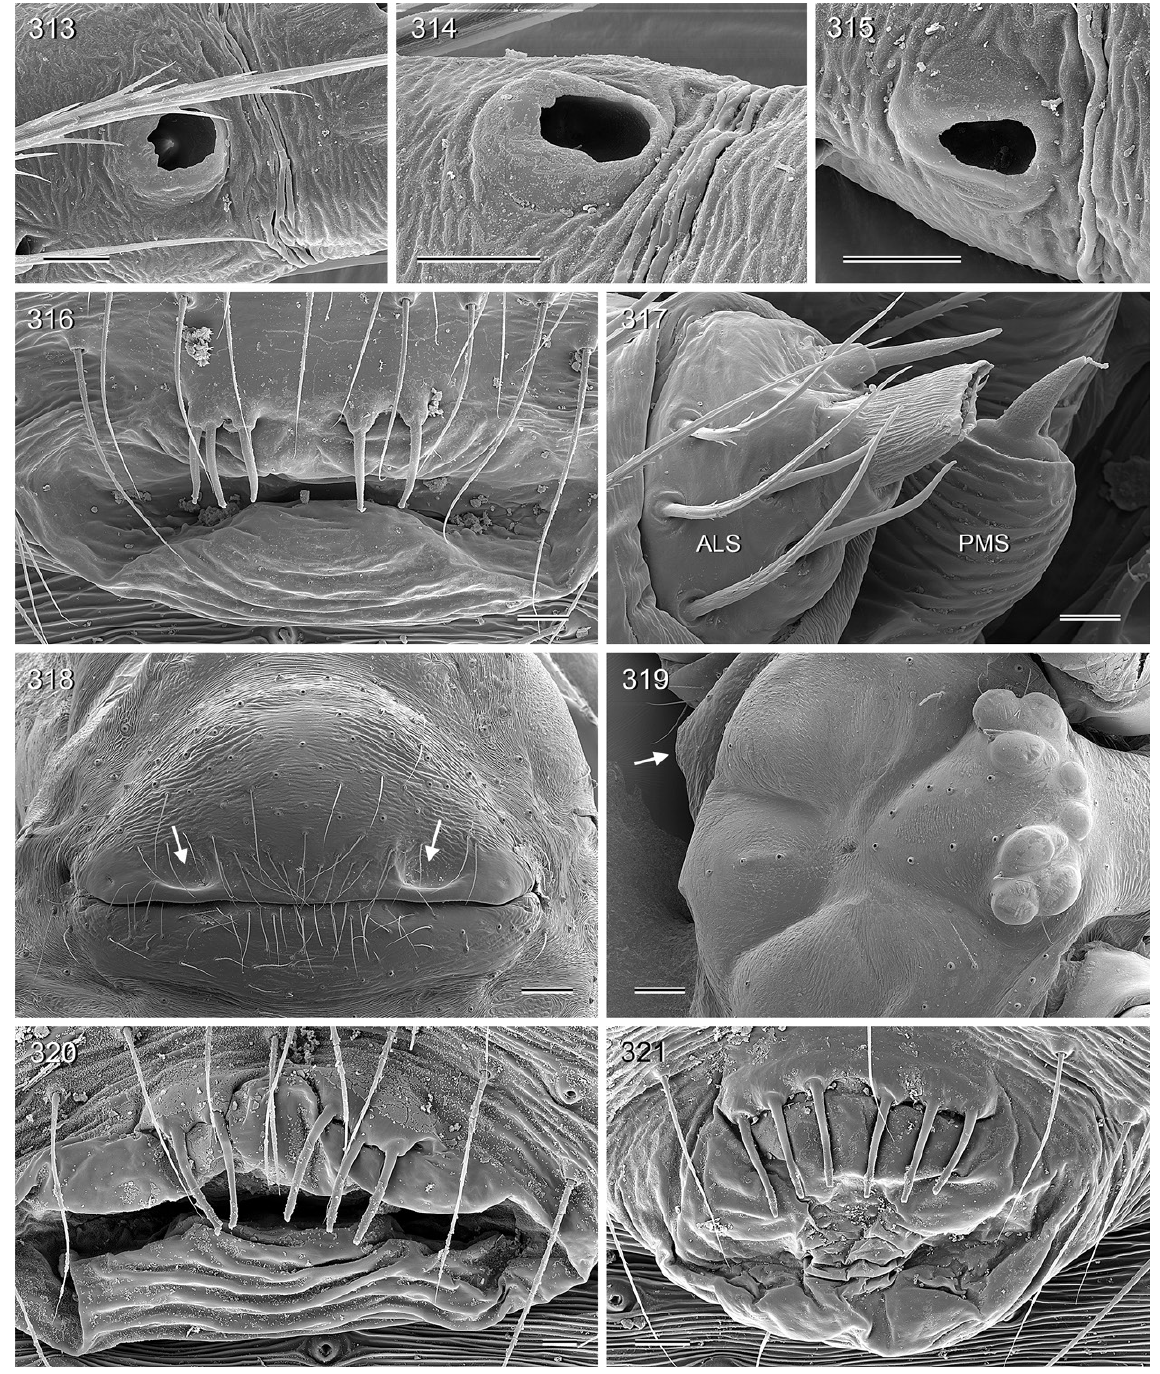
Figs 313–321. 313–318 . Maghreba amezyan gen. et sp. nov.; male and female from Morocco, between Lakhssas and Bouizakarne (ZFMK Ar 22353, Ar 22354). 313–315 . Tarsal organs on male tarsi 1, 2, and 4. 316 . Male gonopore. 317 . Female spinnerets. 318 . Epigynum; arrows: pockets (pits). 319– 321 . Maghreba aurouxi (Barrientos, 2019) gen. nov.; males and female from Morocco, SE of Zebzat (ZFMK Ar 22385, Ar 22886). 319 . Female carapace; arrow: posterior process. 320–321 . Gonopores of two male specimens. Scale bars: 313–315, 317, 320 = 10 µm; 316, 321 = 20 µm; 318–319 = 100